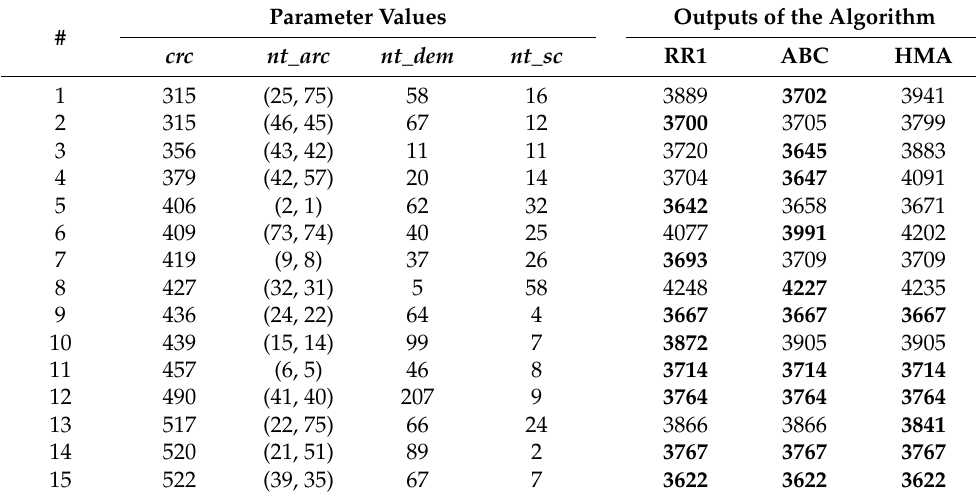
Table 8. The best total costs of 15 independent runs, calculated by the RR1, ABC, and HMA within one minute, after the occurrence of a random task appearance event in the “egl-e1-A”